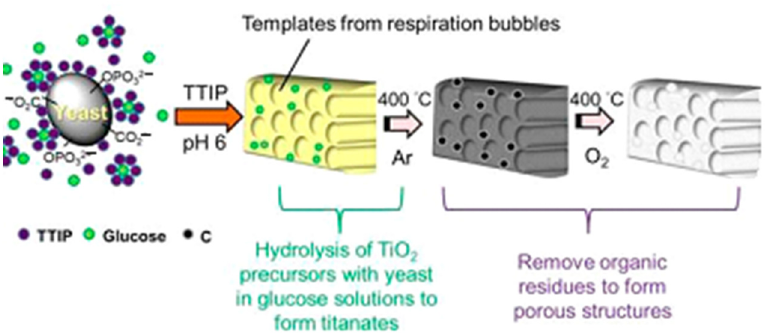
Figure 15. Proposed pathway for the formation of channel-like porous TiO 2 . Reprinted with permis- sion from [31].